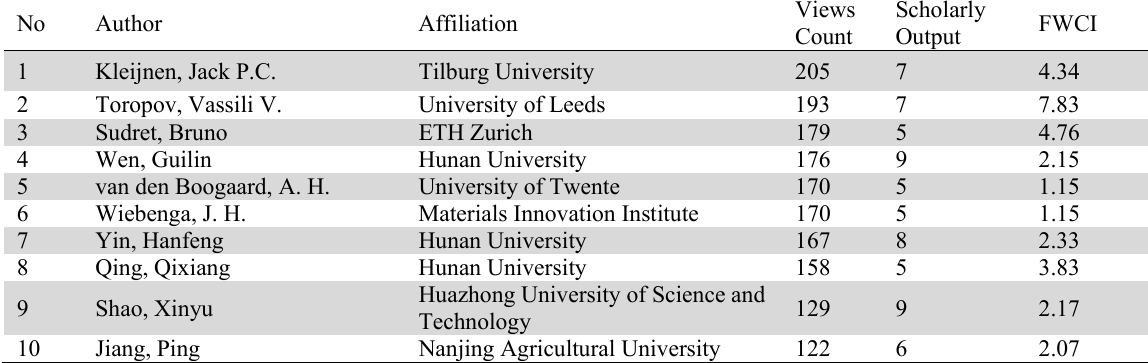
Top ten high view counts authors in field MBSO.